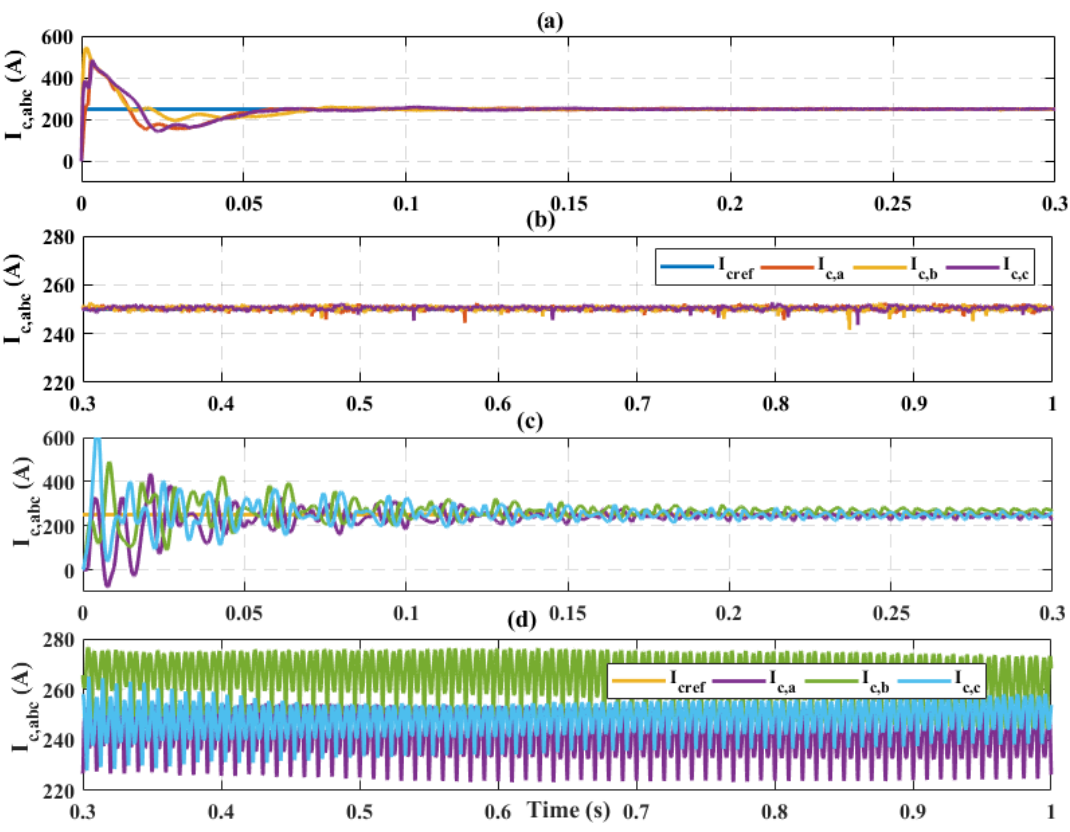
Figure 11 . Current with references ( a )( b ) control with SMC; ( c )( d ) control with PR . Figure 11. Current with references ( a , b ) control with SMC; ( c , d ) control with PR.